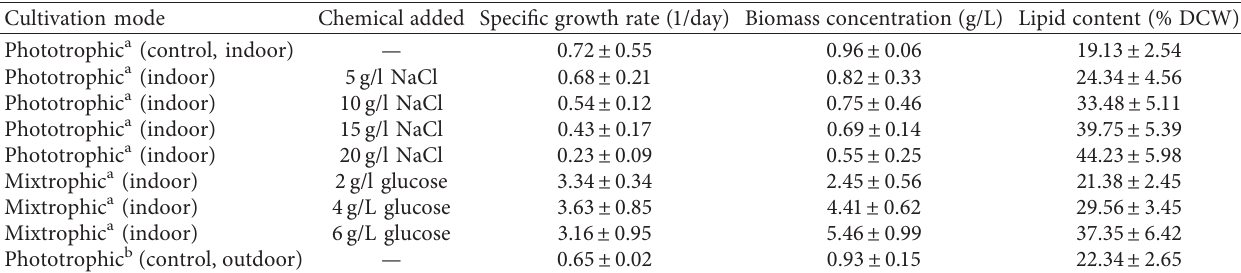
Table 3: Specific growth rate, biomass concentration, and lipid contents of C. sorokiniana TH01 grown under different conditions ( n � 3). Cultivation mode